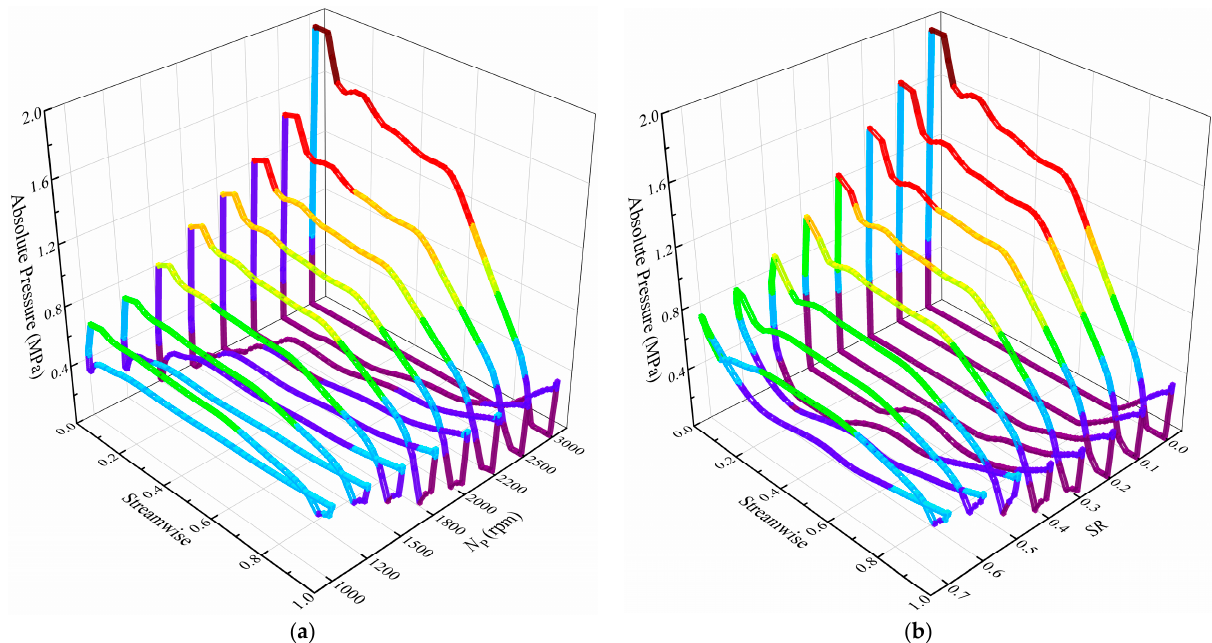
Figure 22. The absolute pressure on stator blade under various conditions. ( a ) Under various N P when SR = 0. ( b ) Under various SR when N P = 3000 rpm.